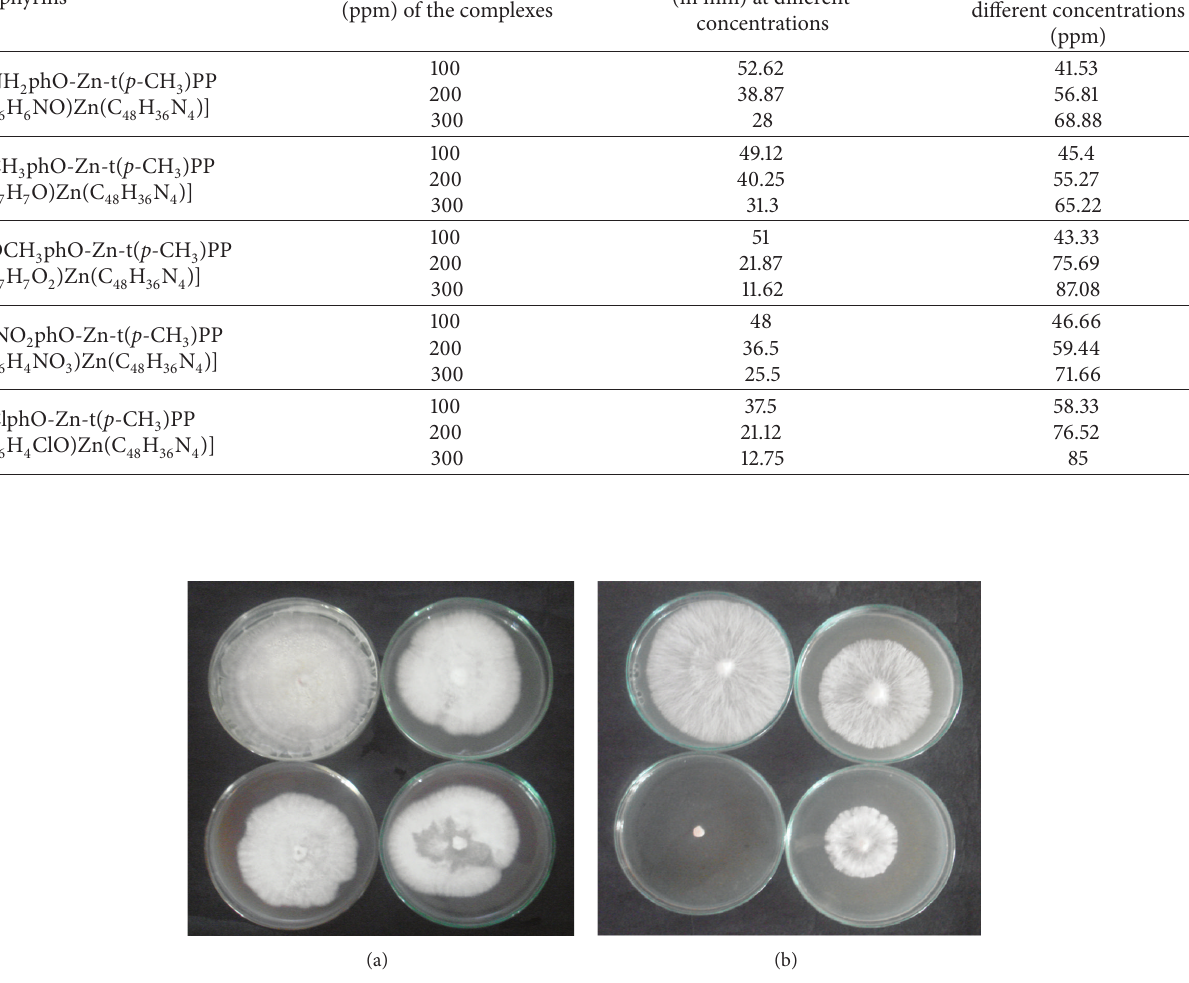
)PP (X = different phenols as axial ligand) against the pathogen Sclerotium rolfsi . 3